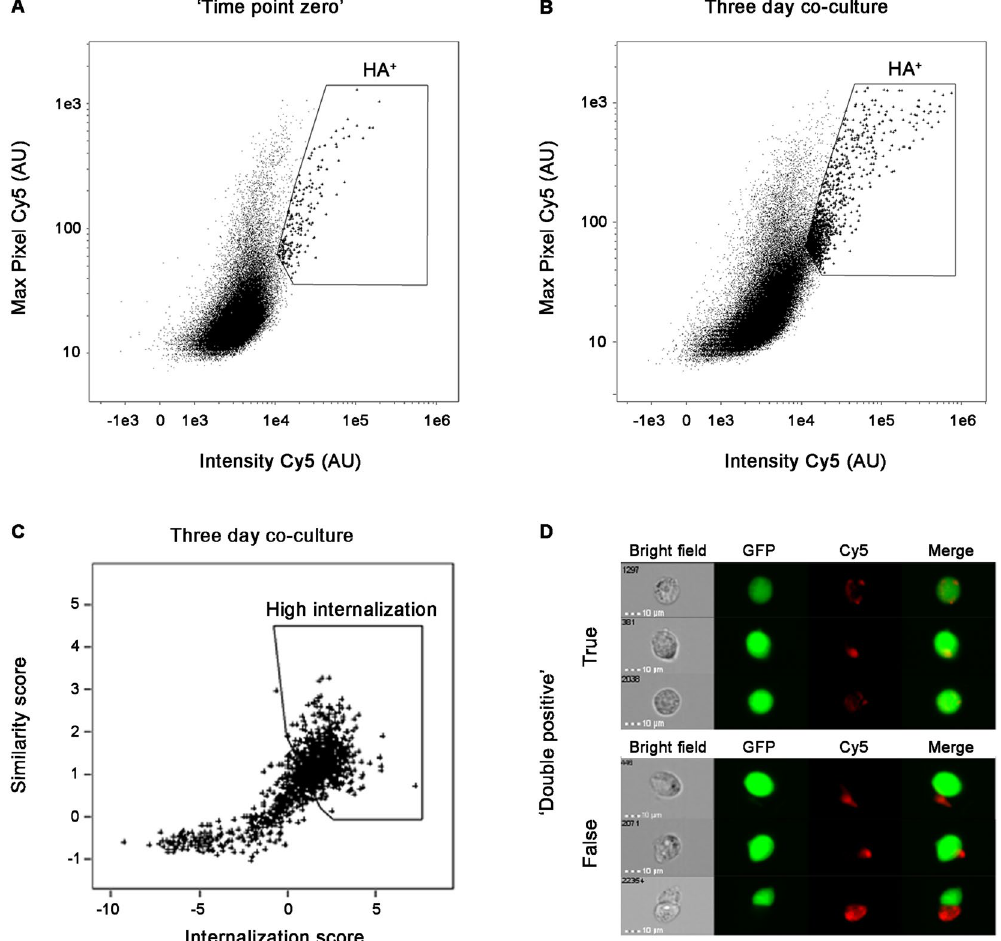
Figure 3. IFC analysis of GFP-expressing ‘recipient’ cells co-cultured with ‘donor’ cells expressing HA-tagged α -synuclein. ( A , B ) Bivariate analysis of GFP-expressing ‘recipient’ cells collected from ( A ) ‘time point zero’ and ( B ) three day co-culture. HA + gated cells are demarcated. ( C ) Double positive (HA + ) cells collected after three days co-culture were further gated to exclude Cy5 staining outside cell boundaries using the Internalization score and the Similarity score between the GFP and Cy5 channels (see Materials and Methods for details). The gated cells represent a high Internalization score within the GFP-expressing cells. ( D ) Images representing true and false ‘double positive’